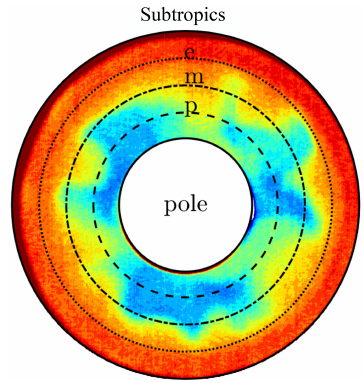
Figure 6. Three regions of the domain and location of the baroclinic wave: polar region (between the inner ring and the circle marked with p), mid-latitudes (between p and m), and subtropical regions (between e and the outer ring). The colours show the temperature measured for the experiment at (cid:49)T = 4 .